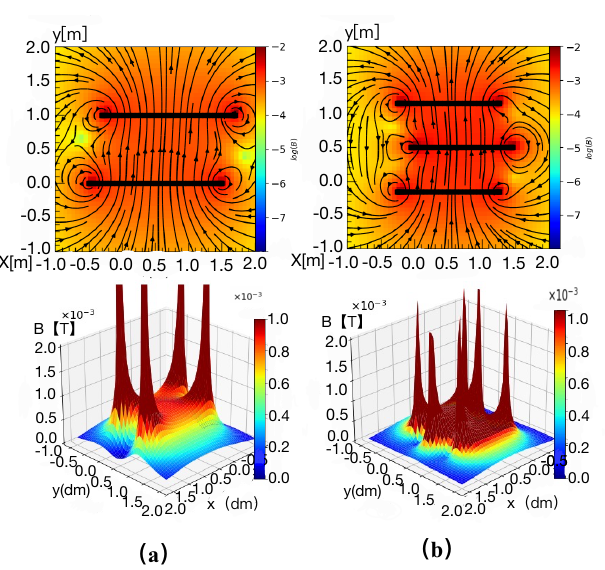
Figure 8. Figure 8a shows a schematic diagram of the magnetic field of the conventional wireless energy transmission structure, and Figure 8b shows the proposed wireless energy transmission structure, and it can be observed from the figure that after the misalignment of the transmitting coil and the receiving coil occurs, the magnetic field at the receiver coil position of the proposed dual transmit coil structure is significantly better than that of the single transmit coil, which is consistent with the theoretical analysis.